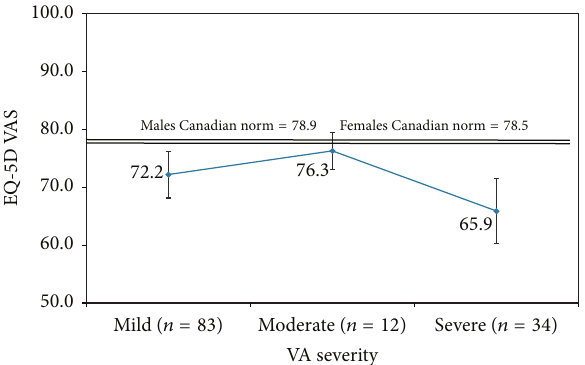
Figure 4: Mean EQ-5D visual analogue scale (VAS) scores and 95% confidence intervals at 6 months by visual acuity